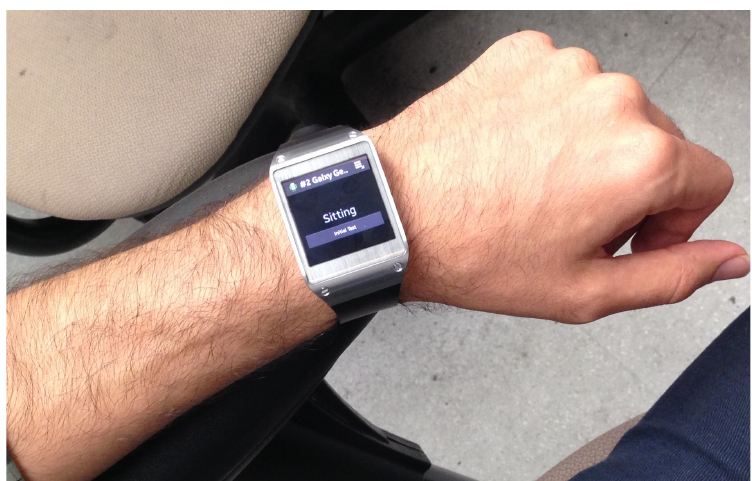
Figure 1. Image of a user wearing the